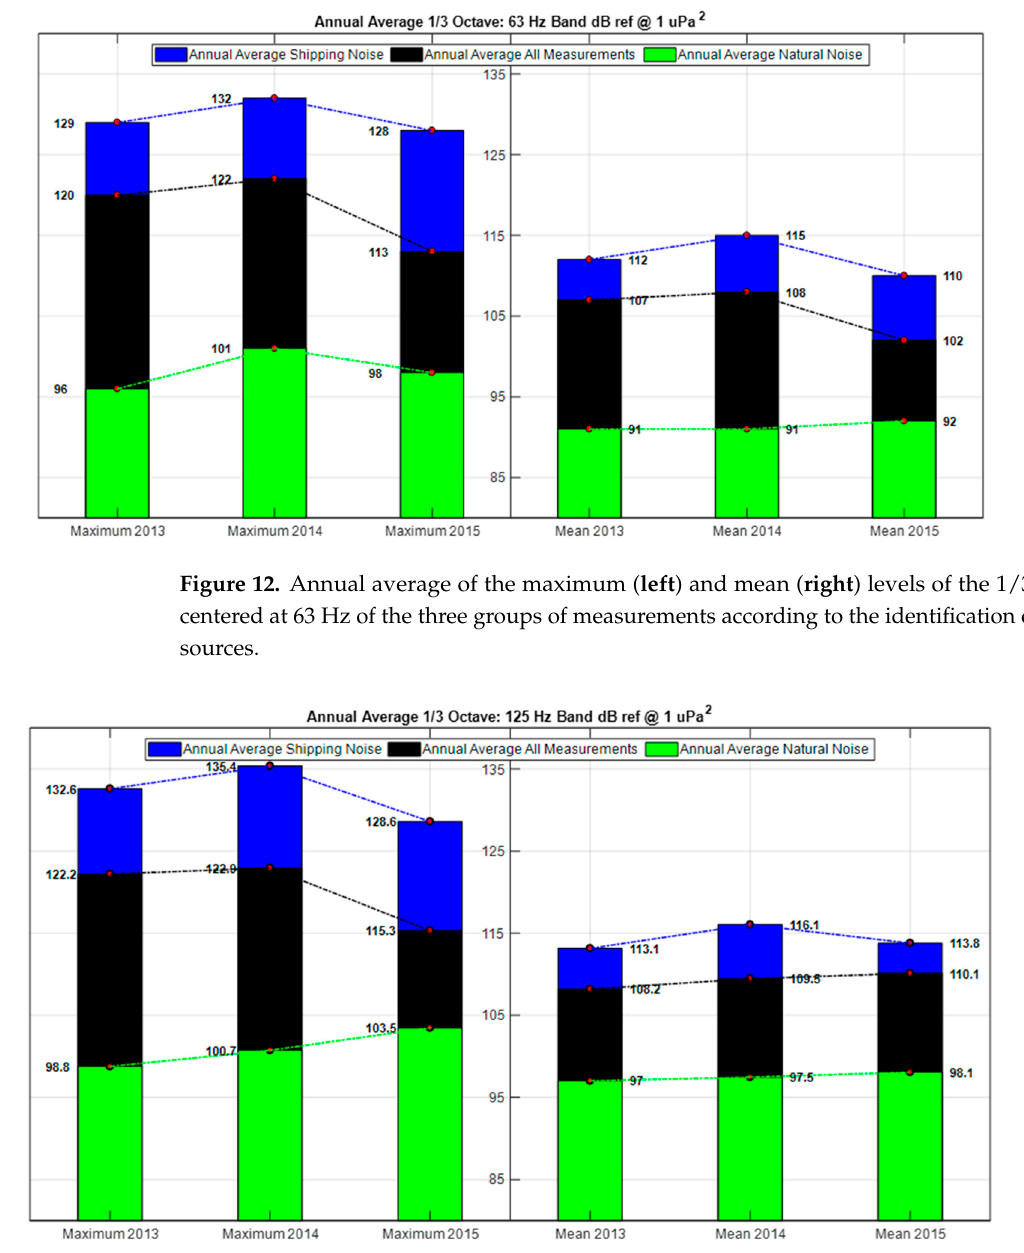
Figure 13. Annual average of the maximum ( left ) and mean ( right ) levels of the 1/3 octave band centered at 125 Hz of the three groups of measurements according to the identification of the acoustic sources.